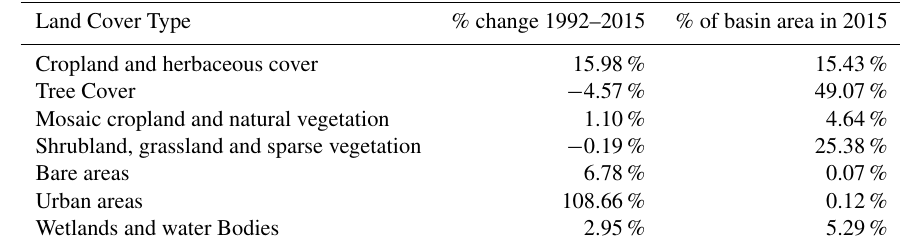
Table 2. Percentage changes in land cover from 1992 to 2015.